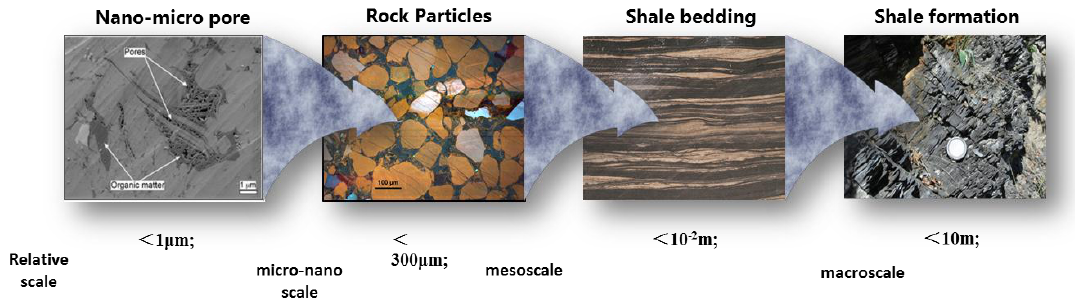
Figure 1. Multi-scale heterogeneity of reservoir system in shale